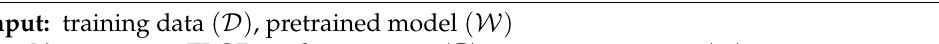
Algorithm 1 Algorithm of